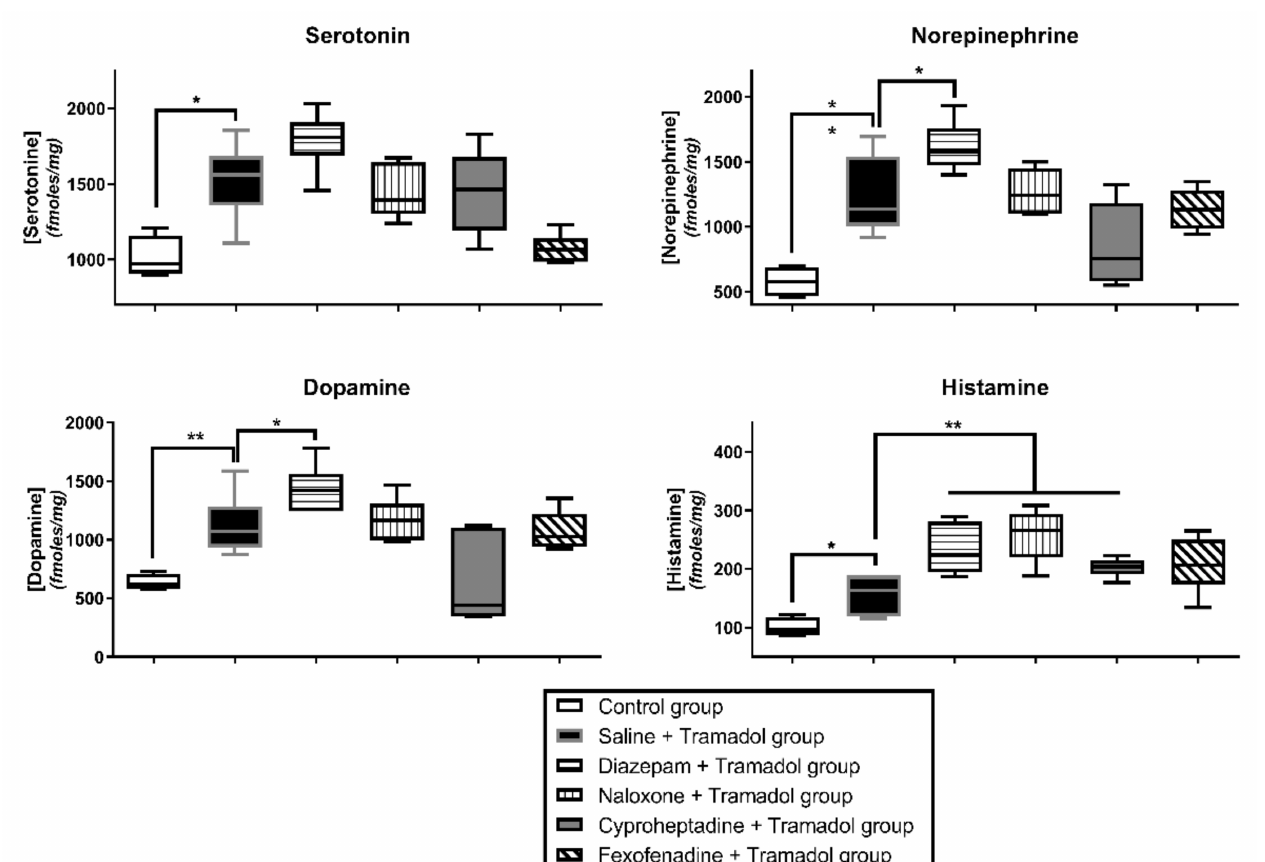
Figure 3. Effects on the frontal cortex monoamine concentrations of intraperitoneal (i.p.) 75